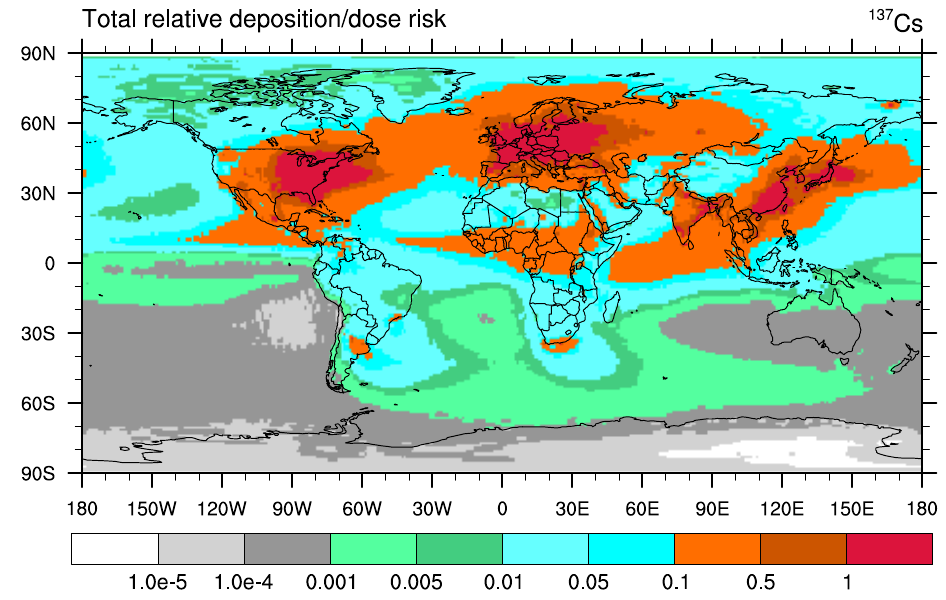
Figure 4. Combined total (operating, under construction, planned or proposed) relative risk by cumulative dry and wet deposition and sedimentation of 137 Cs at the surface from nuclear accidents and equivalent effective dose risk to the population from exposure-related ground contamination over the 2010–2030 period; after